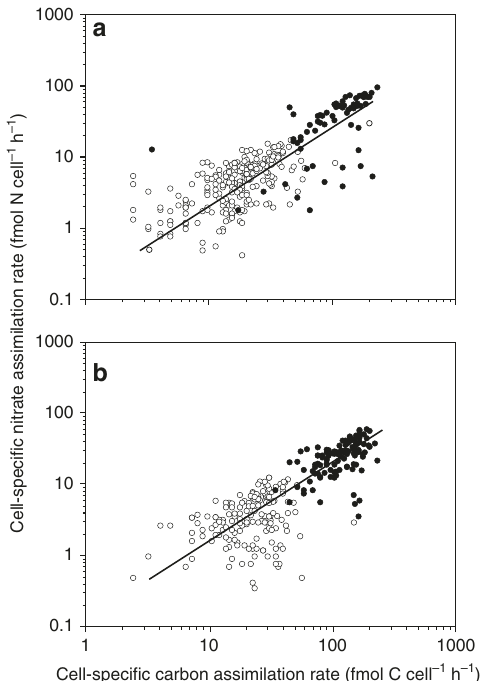
Fig. 3 C- and nitrate-assimilation rates in individual cells. Each symbol represents the rates measured in individual cells of Skeletonema (open symbols) and of Chaetoceros (closed symbols) under still conditions ( a ) and under turbulent shear ( b ). The solid lines represent the Red fi eld ratio